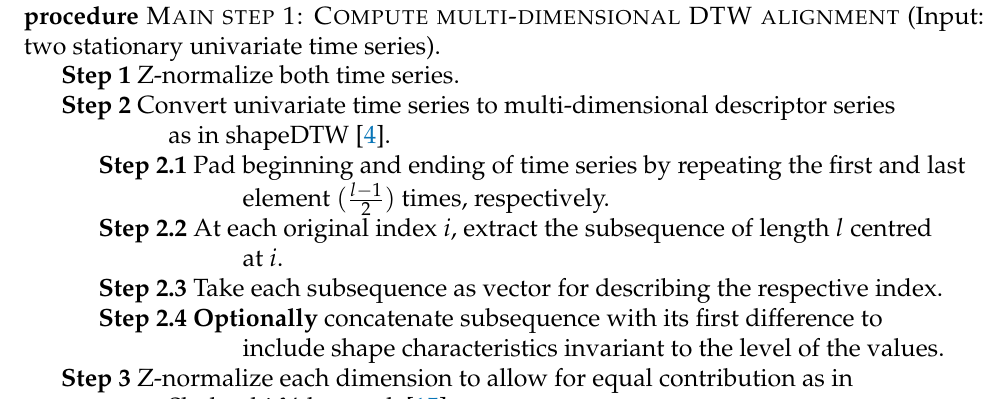
Algorithm 1 Main methodology to identify time-varying lead-lag